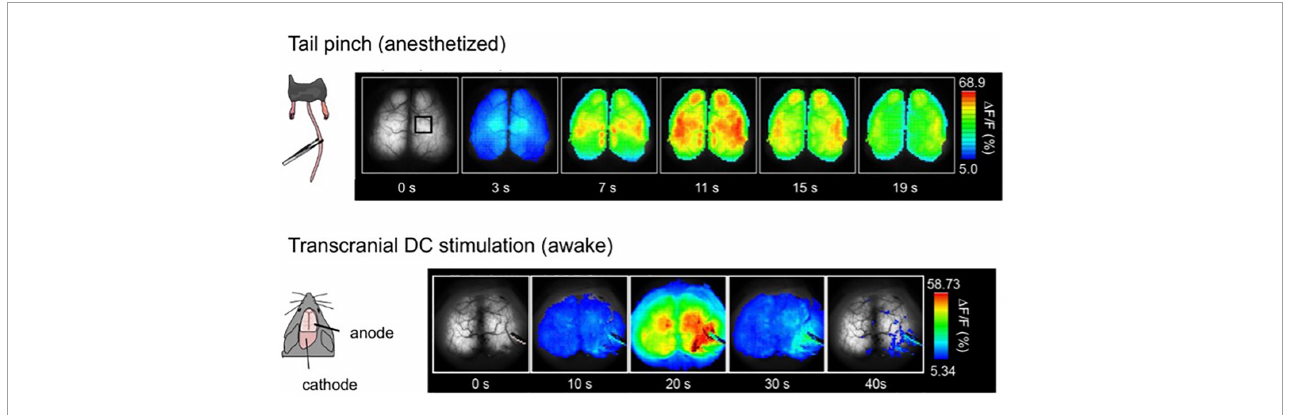
FIGURE7 Global and slow response after tail-pinch and transcranial direct-current stimulation (tDCS). (Top) The tail of the urethane anesthetized mouse is pinched four times for 2 s at time zero. Pseudocoloring is superimposed on the raw images. (Bottom) Awake mice were fixed by their head with a metal head plate attached to the skull with dental cement. tDCS anode was placed on the right hemisphere, and the cathode was on the neck muscle. Weak direct current, 0. 1 mA, was applied for 10 min [Modified from Monai et al.